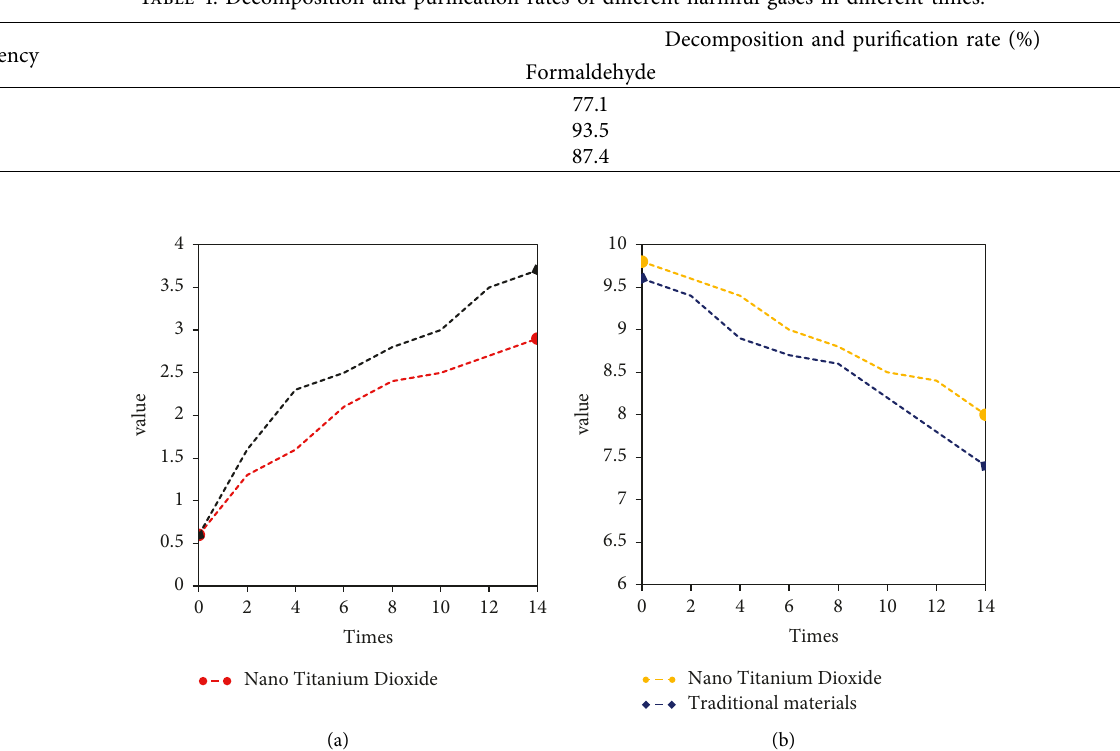
Table 4: Decomposition and purification rates of different harmful gases in different times.